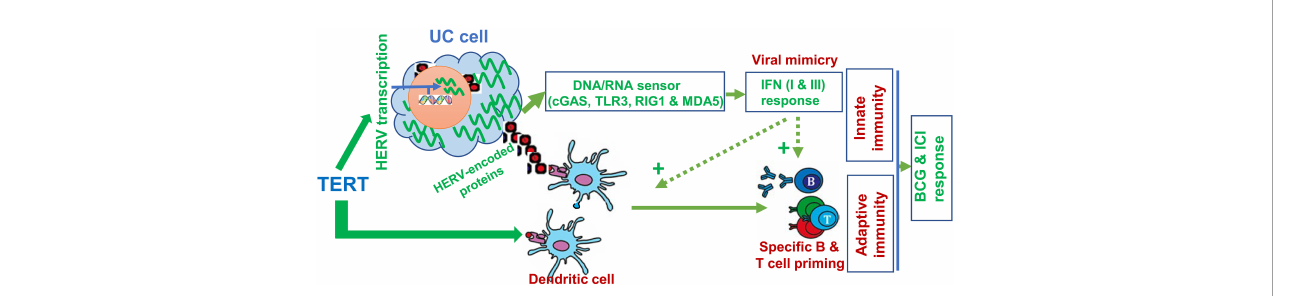
FIGURE 4 TERT-mediated anti-cancer immunity via activation of human endogenous retrovirus (HERV) transcription and as a tumor-associated antigen. In normal somatic cells, HERVs are transcriptionally repressed. While cells undergo malignant transformation, oncogenic events disrupt HERV repression mechanisms, triggering their reactivation and/or accumulation. Overexpressed TERT stimulates HERV transcription. Expression of HERV proteins/peptides (red squares) serves as neoantigens to stimulate adaptive immunity. Moreover, HERV transcripts are recognized as pathogenic nucleic acids to activate innate immune response via the IFN pathway, so-called “ viral mimicry ” . In addition, TERT is itself a tumor-associated antigen, and telomerase-based vaccination stimulates adaptive immunity. Thus, anti-cancer immunity may be signi fi cantly augmented by HERV reactivation and TERT vaccination, and in that case, better ef fi cacy of ICIs may be